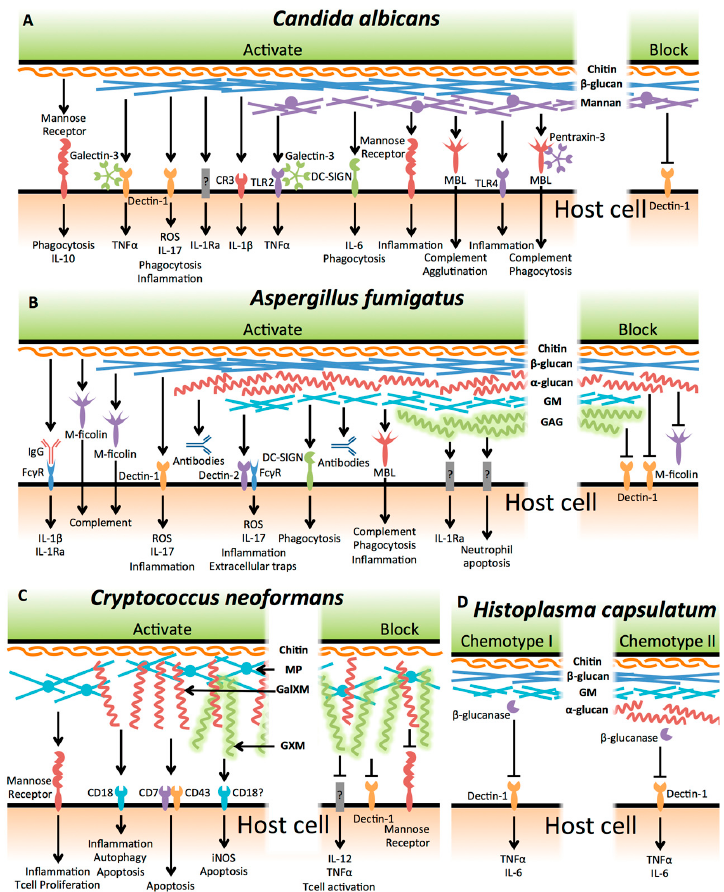
Figure 1. Graphical overview of interactions between fungal polysaccharides and host elements. ( A ) Candida albicans ; ( B ) Aspergillus fumigatus ; ( C ) Cryptococcus neoformans ; and ( D ) Histoplasma capsulatum . Abbreviations used: CR3, complement receptor 3; MBL, mannose-binding lectin; GM, galactomannan; GAG, galactosaminogalactan; MP, mannoprotein; GalXM, galactoxylomannan; GXM, glucuronoxylomannan. Green indicates fungal cell, and tan, the host cell.